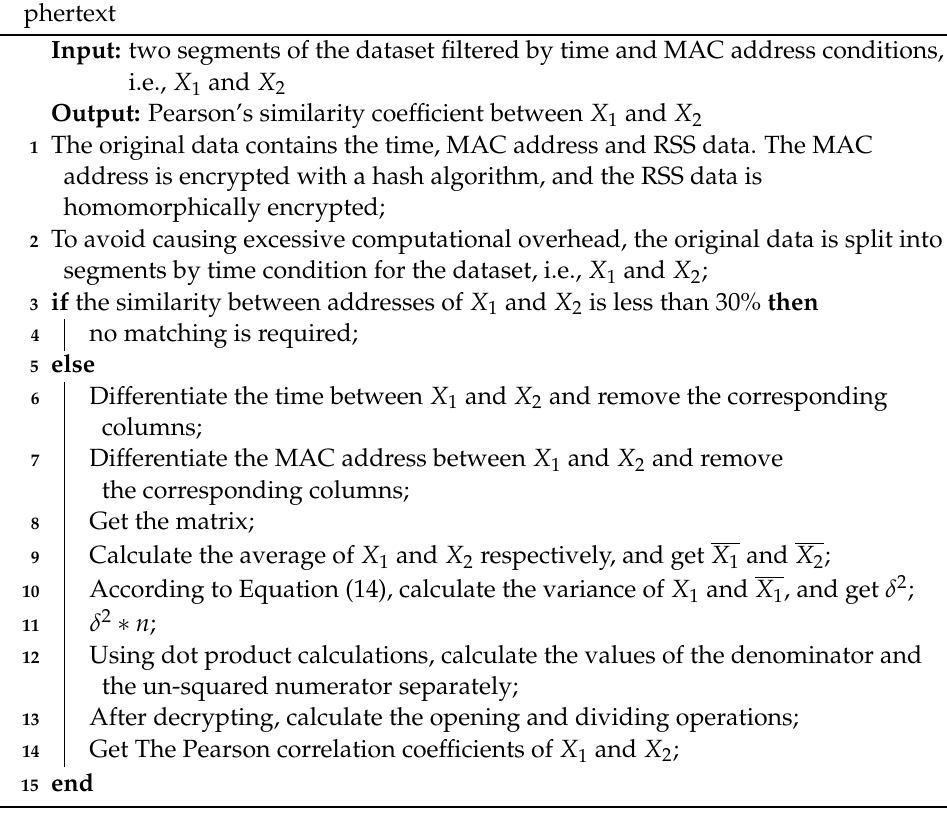
Algorithm 1: Algorithm for calculating Pearson’s correlation coefficient for ci- phertext